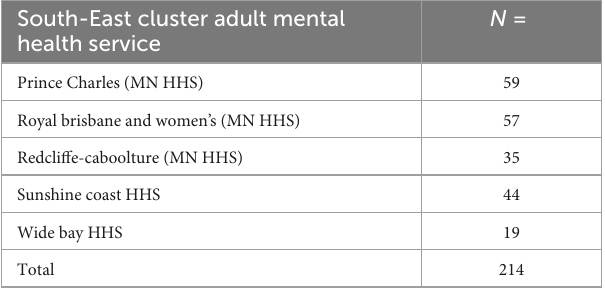
TABLE 2 Inclusion and exclusion criteria.